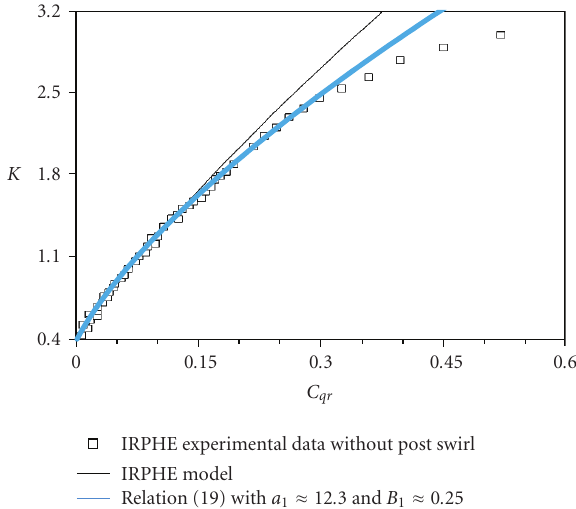
IRPHE model Relation (19) with a 1 ≈ 12 . 3 and B 1 ≈ 0 . 25 Figure 13: Core swirl ratio distribution deduced from (19). Comparison with experimental and numerical results from Poncet [17].